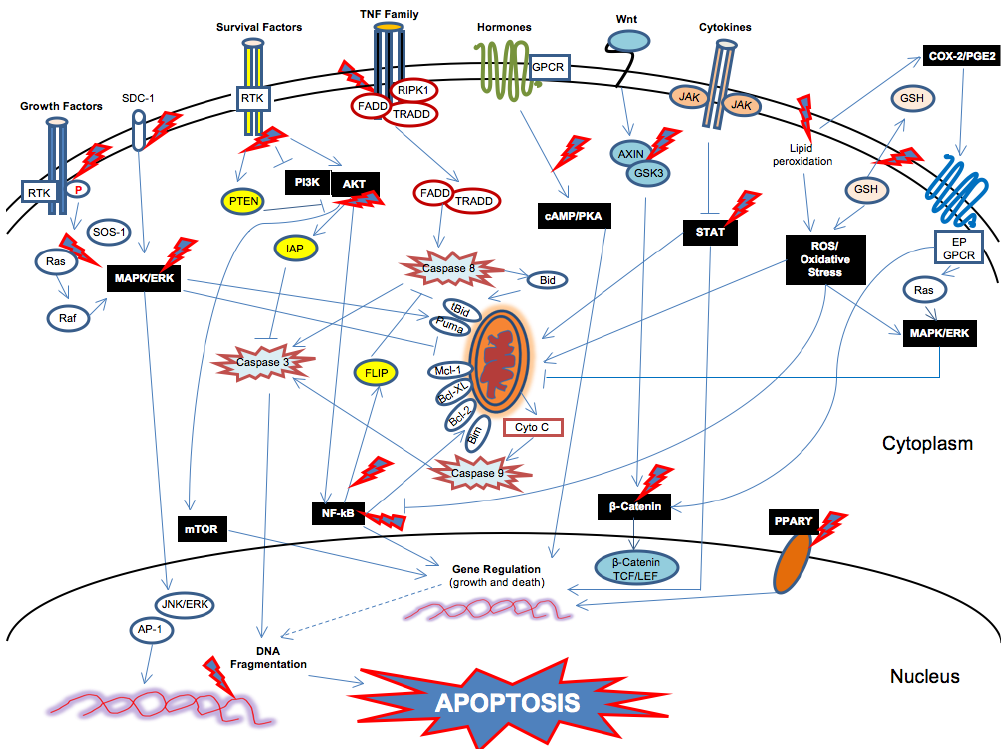
Figure 1. Multiple apoptotic molecular signals targeted by n ‐ 3 PUFAs in cancer cells. Abbreviations: RTK, protein tyrosine kinase; SOS ‐ 1, son of sevenless ‐ 1; Erk, extracellular ‐ signal ‐ regulated kinase; MAPK, mitoge n ‐ activated protein kinase; JNK, Jun N ‐ terminal kinase; AP ‐ 1, activator protei n ‐ 1; SDC ‐ 1, syndeca n ‐ 1; PTEN, phosphatase and tensin homolog deleted on chromosome ten; PI3K, phosphatidylinositol ‐ 3 ‐ kinase; mTOR, mammalian target of rapamycin; IAP, inhibitor of apoptosis; NF ‐κ B, nuclear factor ‐κ B; FLIP, FLICE ‐ like inhibitory protein; RIPK ‐ 1, receptor ‐ like protein kinase ‐ 1; FADD, Fas ‐ associated death domain; TRADD, TNF receptor ‐ associated death domain; Bcl ‐ 2, B ‐ cell lymphoma protei n ‐ 2; Bim, Cyto C, cytochrome C; GPCR, G ‐ protein coupled receptor; cAMP, cyclic adenosine monophosphate; PKA, protein kinase A; GSK, glycogen synthase kinase; TCF, T ‐ cell factor; LEF, lymphoid enhancer ‐ binding factor; JAK, Janus kinase; STAT, signal transducer and activator of transcription; ROS, reactive oxygen species; GSH, glutathione; COX ‐ 2, cyclooxygenase ‐ 2; PGE2, prostaglandin E2; PPAR ‐γ , peroxisome proliferator ‐ activated receptor γ . arrows , activation; ┴ , inhibition; dashed arrows , indirect action; red/blue flash, targeted by n ‐ 3 PUFAs.